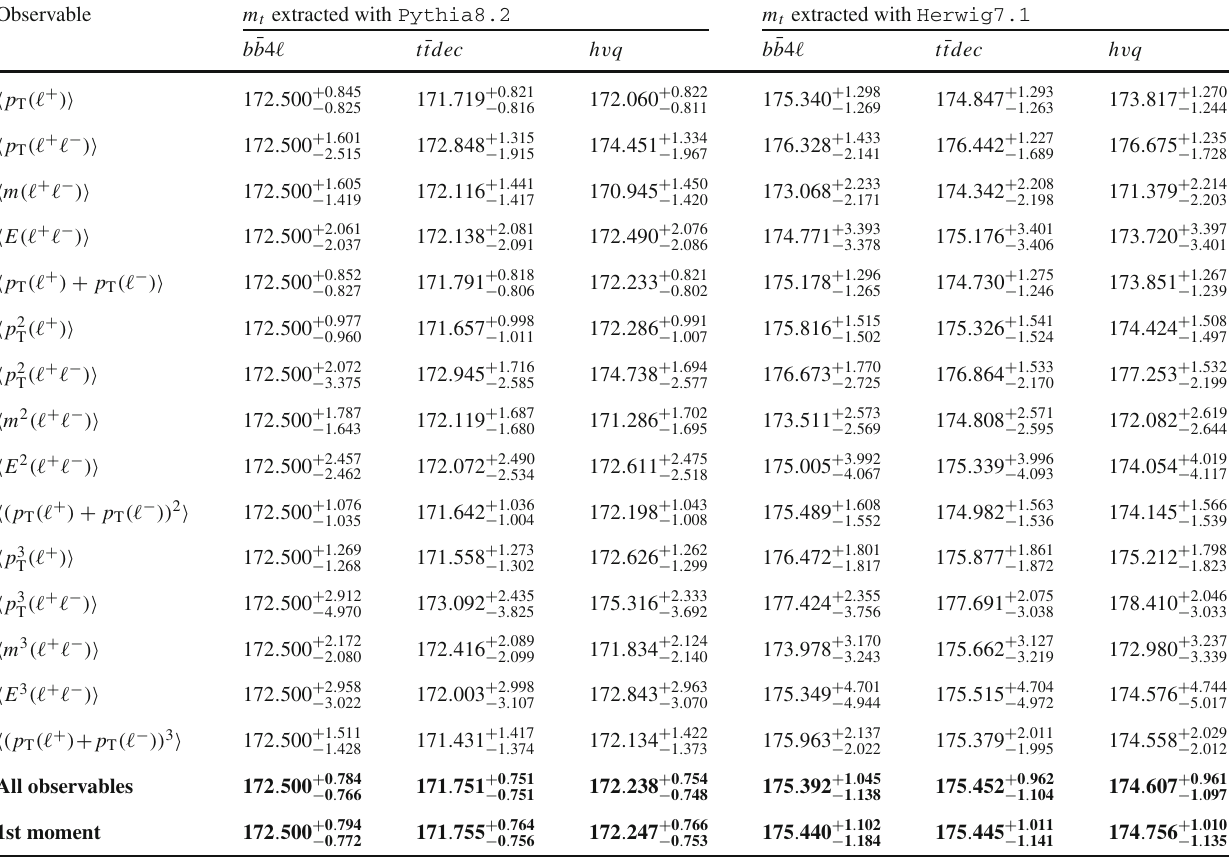
Table 23 Extracted mass in GeV for all the generators, showered with Pythia8.2 and Herwig7.1 ,corresponding to the different leptonic observables, using as reference sample the b ¯ b 4 (cid:4) one generated with m t = 172 . 5 GeV and showered with Pythia8.2 . The quoted errors